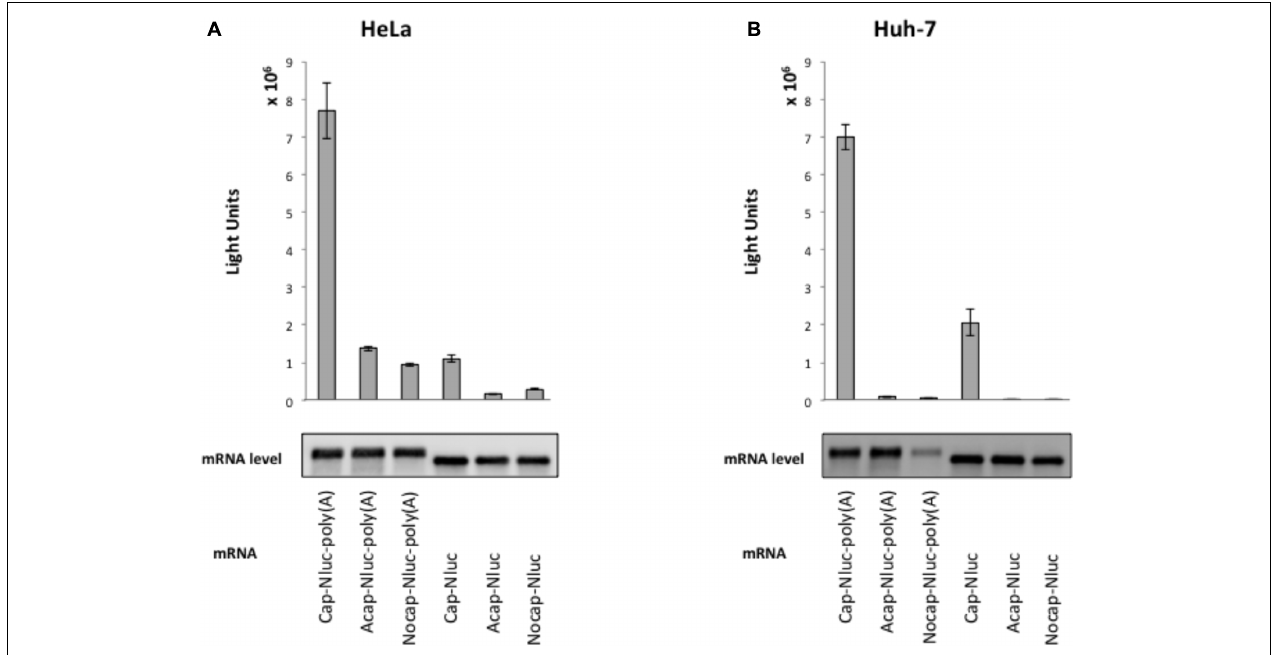
FIGURE 1 | Cap structure and poly(A) tail synergy in the HeLa- and Huh-7-derived cell free translation system. (top panel) HeLa (A) or Huh-7 (B) translation extracts were mixed with the indicated Nanoluc (Nluc) reporter mRNAs at 37 ◦ C for 30 min. The luciferase light units are shown. Error bars reflect the standard deviation of values in at least three independent experiments. (bottom panel) Physical stabilities of the indicated mRNAs at the end of the incubation were analyzed by Northern